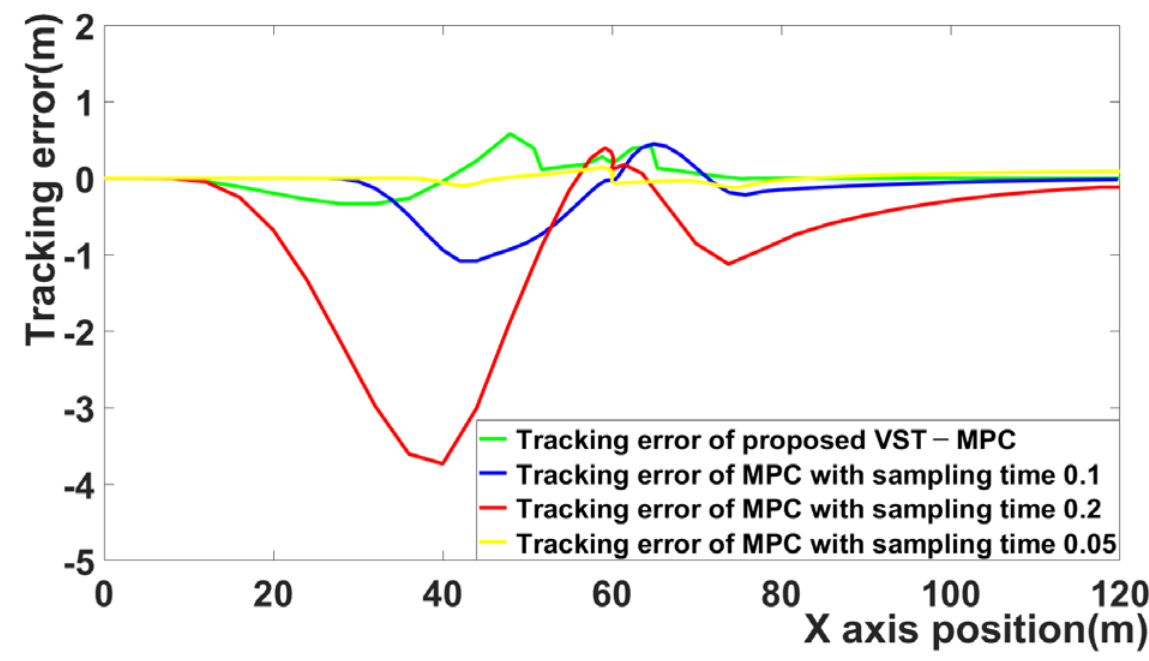
Figure 7. Comparison of tracking error for four MPC algorithms. Table 2. Average tracking error and entire computation time of four MPC algorithms.